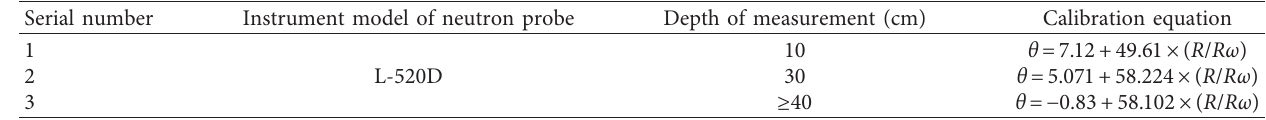
Table 1: Calibration equation of neutron probe in the